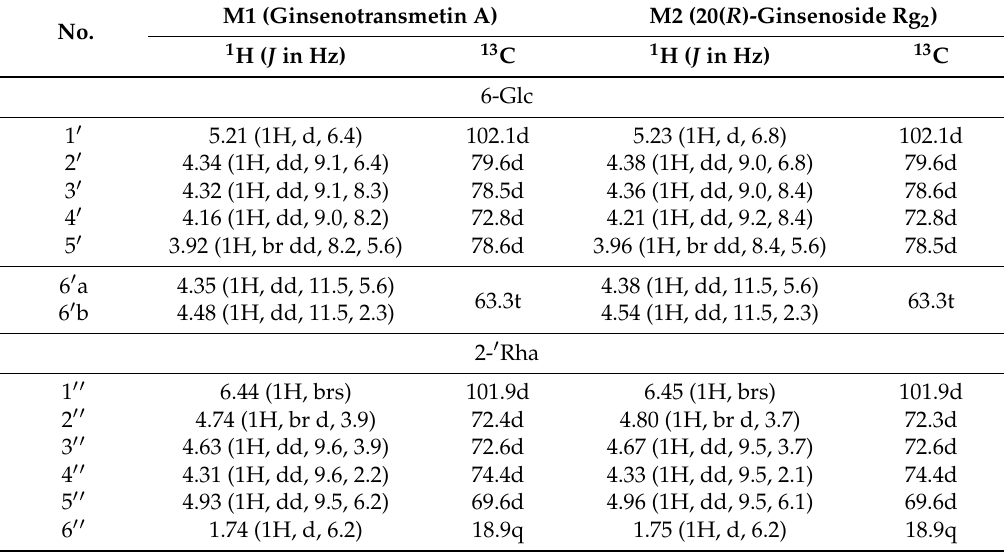
Table 2. 1 H- and 13 C-NMR data in pyridine- d 5 ( δ ppm ) of glycosyl parts of M1 and M2 a .